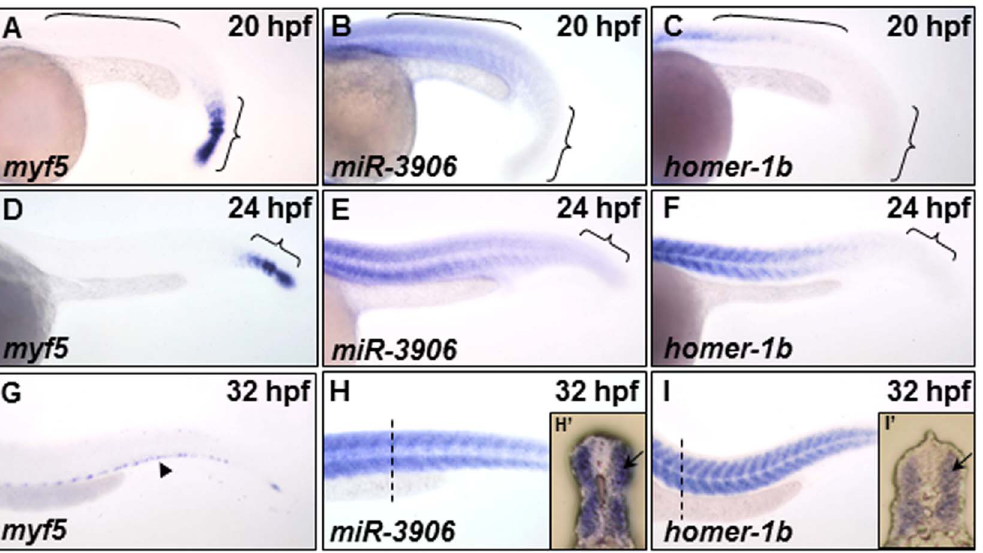
Figure 2. The expression patterns of myf5 , miR-3906 and homer-1b in the trunk somites of zebrafish embryos. ( A, D, G ) Using whole- mount in situ hybridization to detect the temporal and spatial expression patterns of myf5 , ( B, E, H ) miR-3906 and ( C, F, I ) homer-1b in zebrafish embryos at 20 hpf, 24 hpf and 32 hpf. At 20 hpf, ( A ) myf5 was expressed in the pre-somitic mesoderm and newly formed somites (indicated by { ), but it was absent in mature somites (indicated by [); ( B ) miR-3906 and ( C ) homer-1b were detected in mature somites. At 24 hpf, ( D ) myf5 was detected in the pre-somitic mesoderm, while ( E ) miR-3906 and ( F ) homer-1b gradually increased expression in mature somites. At 32 hpf, ( G ) myf5 was expressed in the edge region of trunk muscles (arrowhead), but ( H ) miR-3906 and ( I ) homer-1b were expressed in all trunk muscles. Cross section (dotted lines) showed that ( F’ ) miR-3906 and ( I’ ) homer-1b were expressed in fast muscle (arrows).